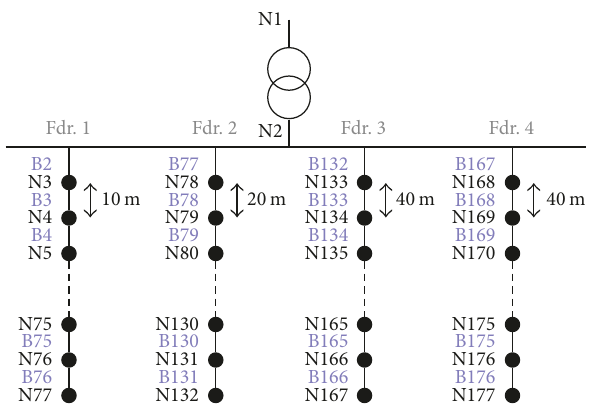
Figure 10: Low voltage grid with 177 nodes used in emergent behavior and scalability methodologies; figure taken from [41].